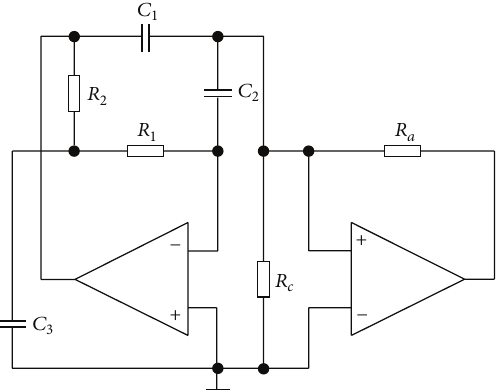
Figure 10: The circuitry implementation of chaotic oscillator for case 𝐴